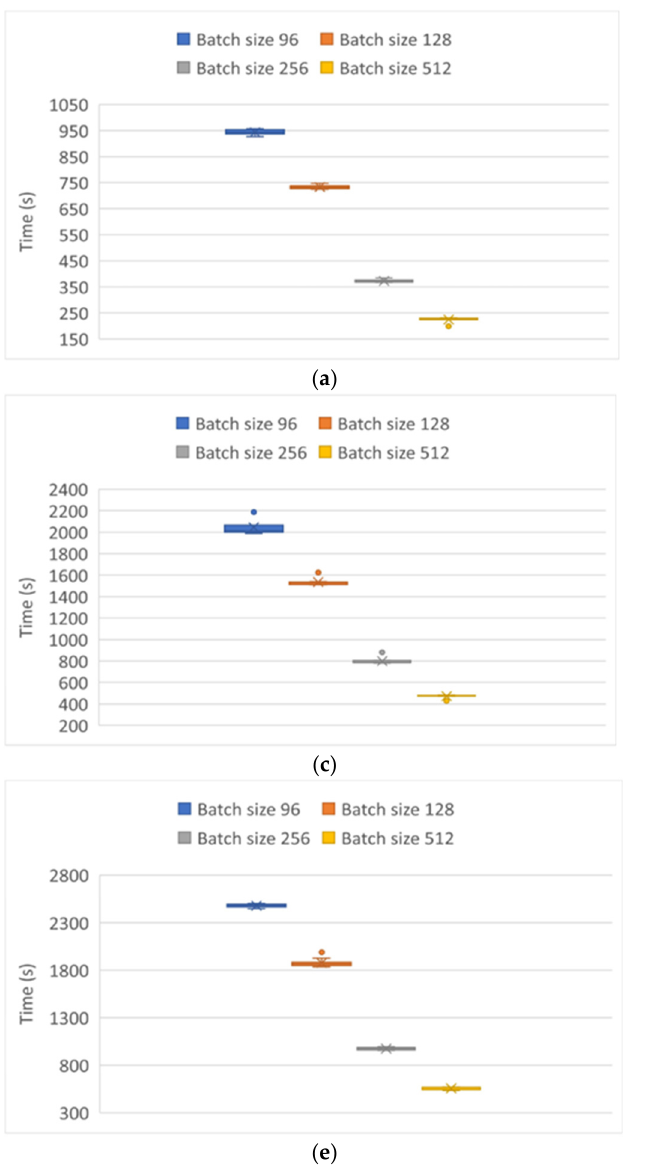
Figure 12. Processing time variability in modeling particle behavior PM 2.5 . ( a ) Elman neural network using Adam optimizer. ( b ) Elman neural network using Adamax optimizer. ( c ) GRU neural network using Adam optimizer. ( d ) GRU neural network using Adamax optimizer. ( e ) LSTM neural network using Adam optimizer. ( f ) LSTM neural network using Adamax optimizer. Table 5. Best hyperparameters for PM 10 particle modeling. Neural Optimizer Batch Size Network